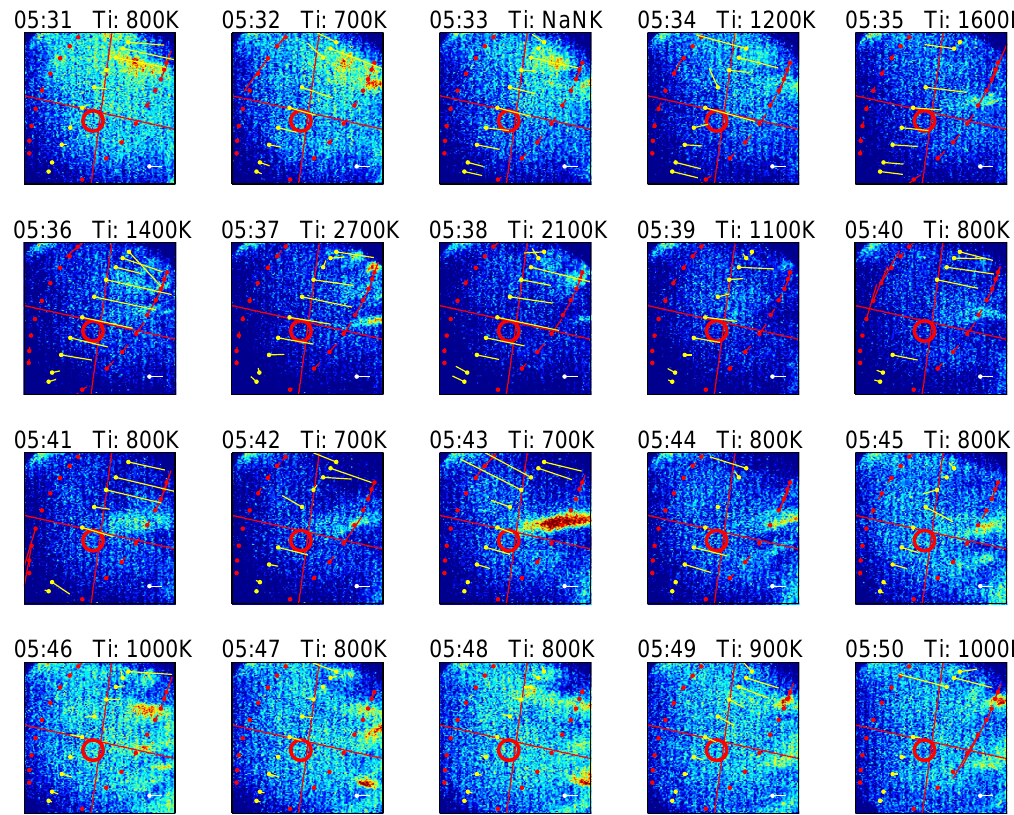
Fig. 6. All-sky images integrated to 1-min time resolution. The x and y axis show pixel number. The ESR field-of-view at 150km is in the center of the red circle. Magnetic meridional and zonal lines are indicated by red lines. Yellow lines starting from a dot indicate the EISCAT CP4 beam-swing derived velocity vectors. The CP4 line-of-sight velocities are shown as red lines originating from dots along the radar beam projection. A white line starting from a dot indicates the length corresponding to 1km/s. The time of observation and ESR ion temperature are indicated above each